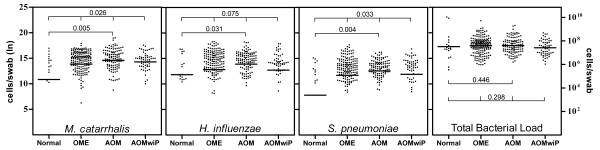
Bacterial load versus Clinical Ear State. The geometric mean bacterial loads are segregated by clinical ear state for each bacterial pathogen. A significantly higher load was seen for M. catarrhalis, H. influenzae and S. pneumoniae in children with AOM compared to Normal ear states (Mann Whitney Wilcoxon test). Significant differences in the loads across the ear states, for M. catarrhalis and S. pneumoniae, were confirmed by the Kruskal-Wallis equality of populations rank test. There was no significant difference in geometric mean of the Total Bacterial Load between ear states.